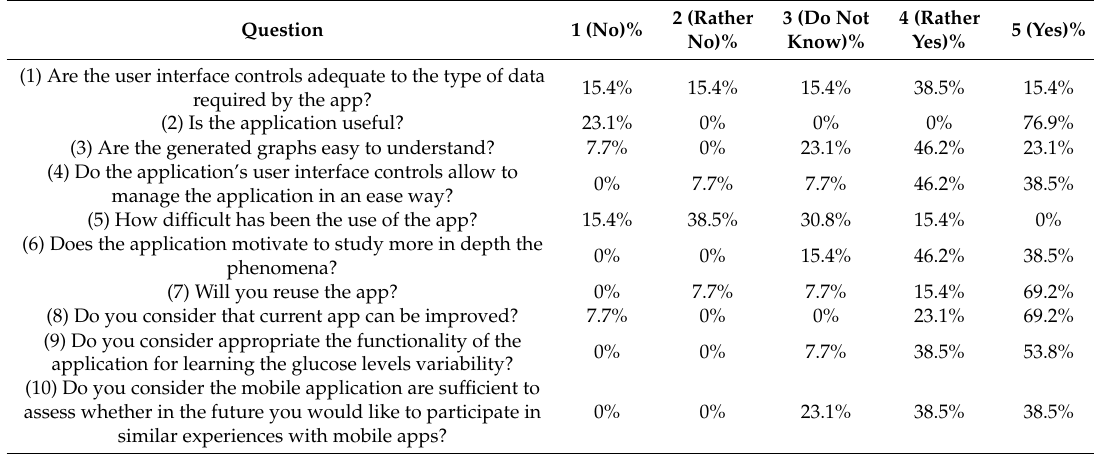
Table 5. Results of the questionnaire for the test